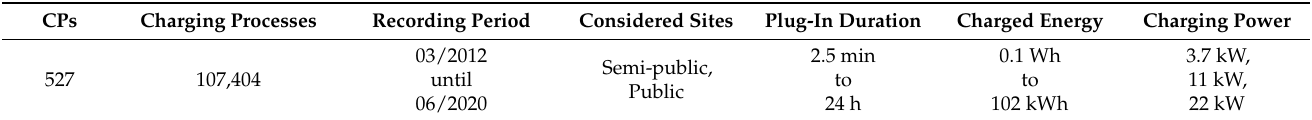
Table 1. Overview of the processed data set.